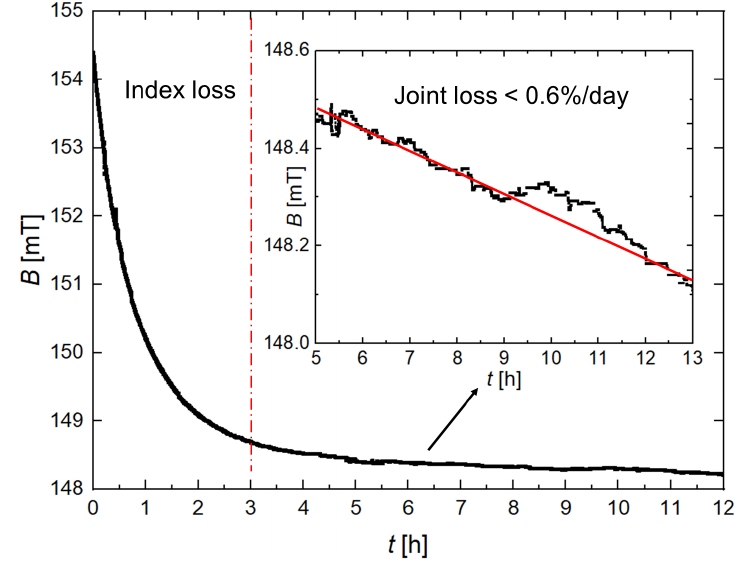
Figure 19. Natural decay curve of the magnetic flux of the DP